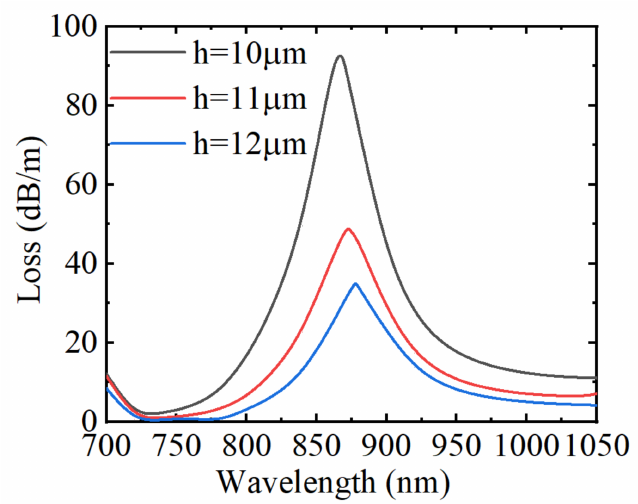
Figure 10. The loss spectrum of the core guide mode under three polishing